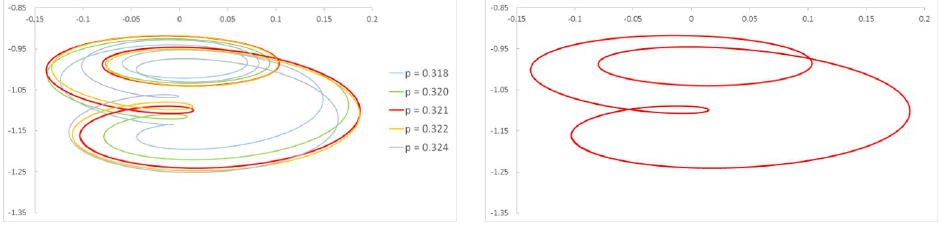
Figure 9. Orbits of the shaft for α = 0.45 within a speed interval close to p = 1